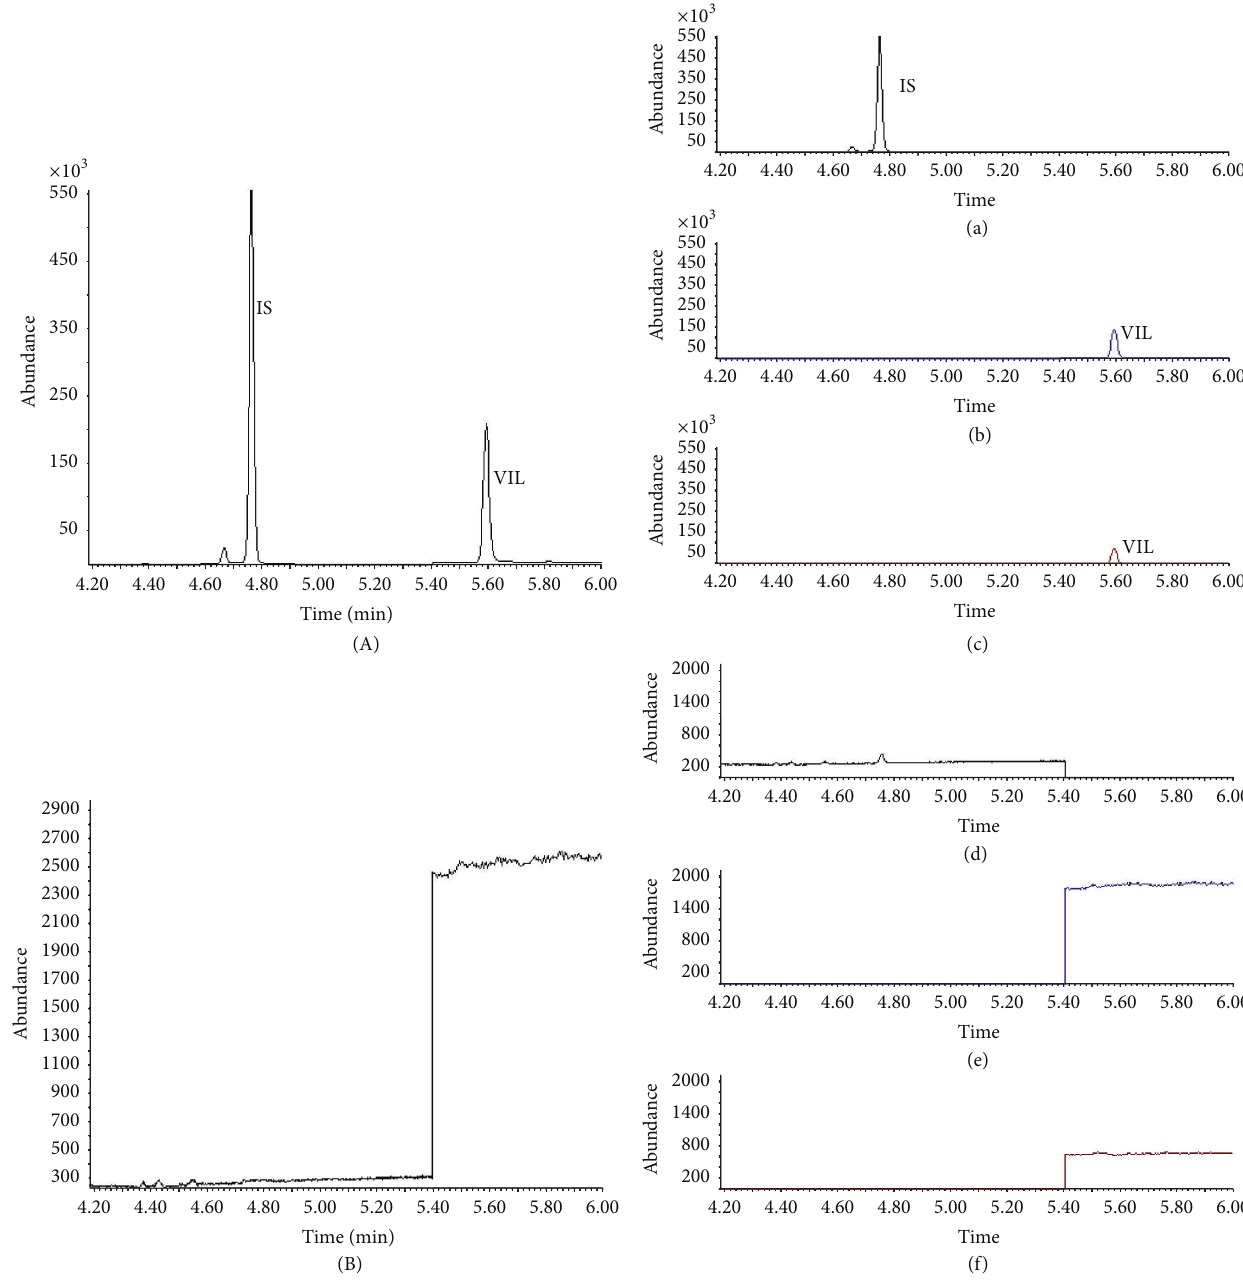
Figure3:(A)TotalionchromatogramofVIL(100 ngmL −1 )andIS.Selectedionchromatogramsfor m/z 418(a),223(b),and252(c)belonging to standard solution containing VIL (100ngmL −1 ) and IS. (B) Total ion chromatogram of the placebo tablet. Selected ion chromatograms